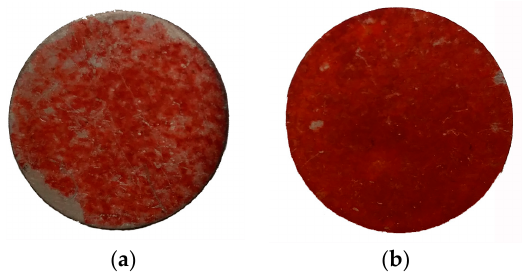
Figure 9. Osteoblast mineralization on ( a ) AC and ( b ) HS specimens.